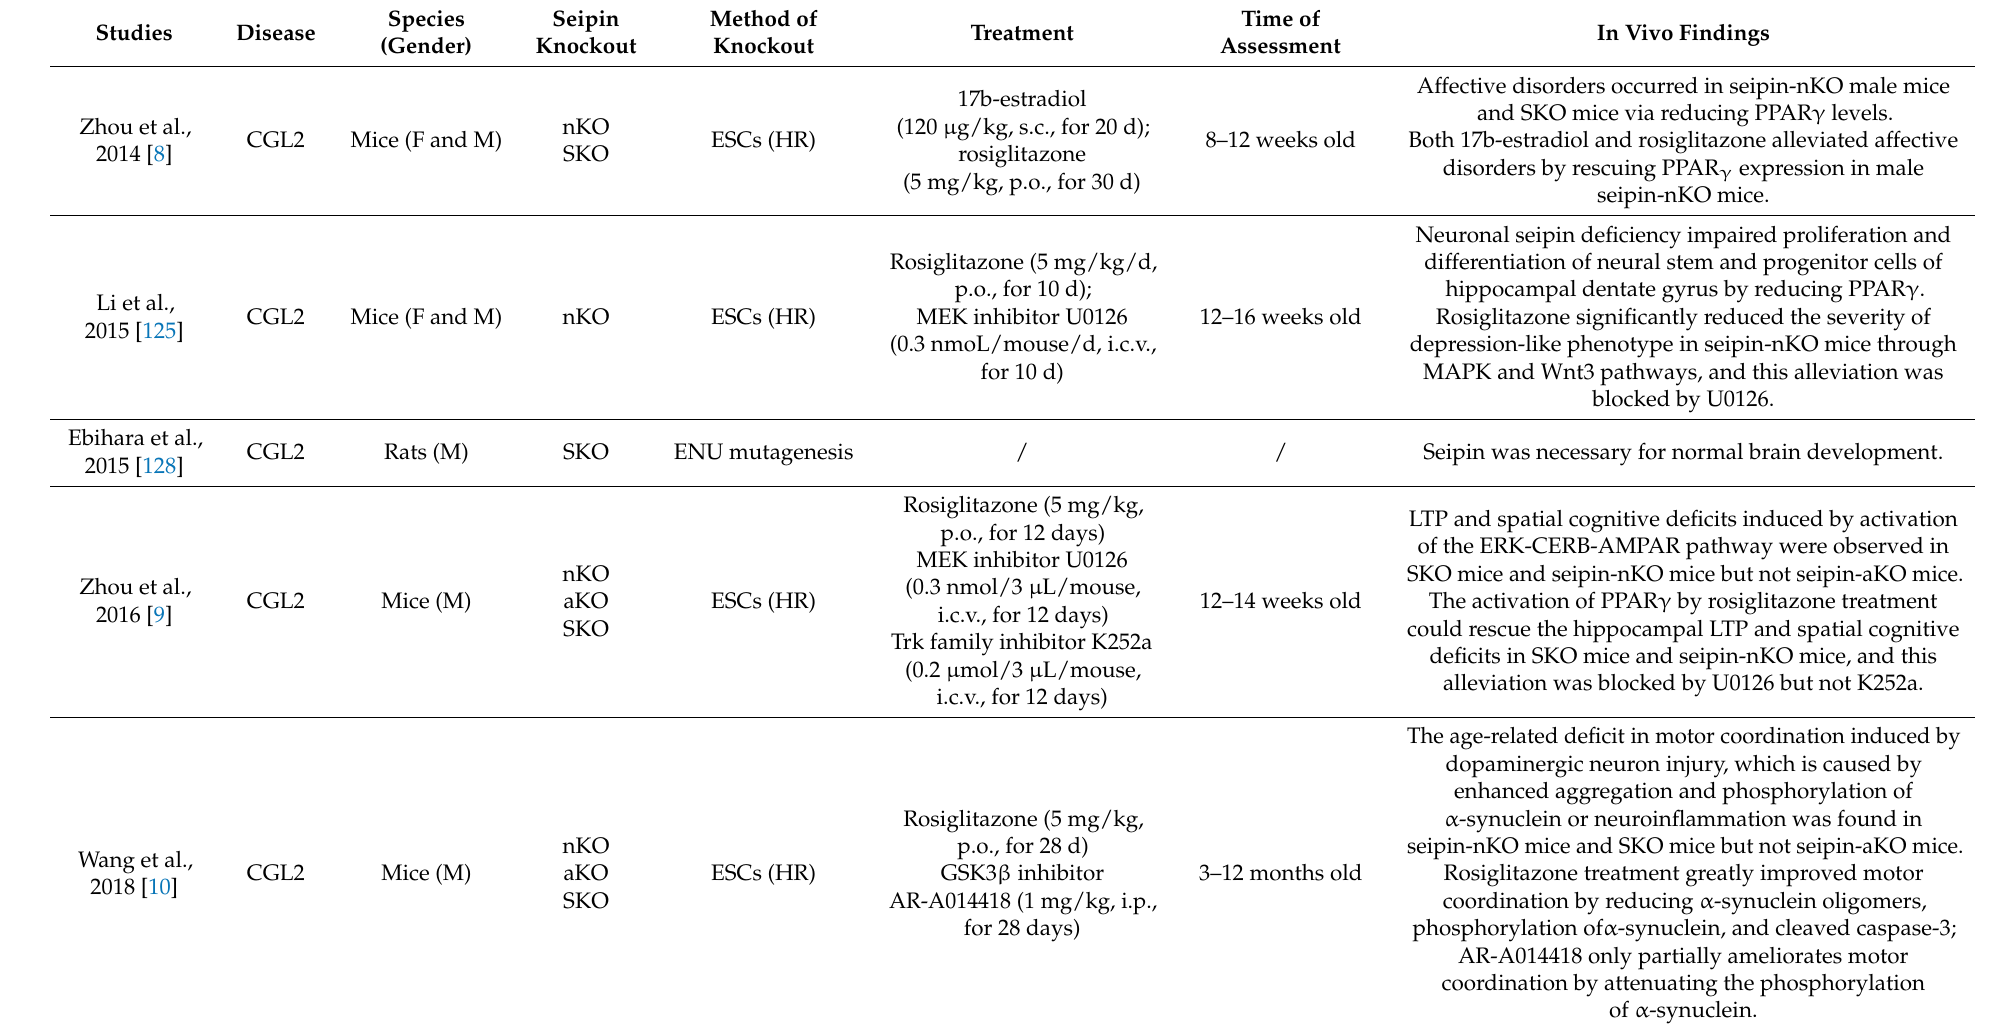
Table 5. Neural disorders of seipin deficiency or overexpression in